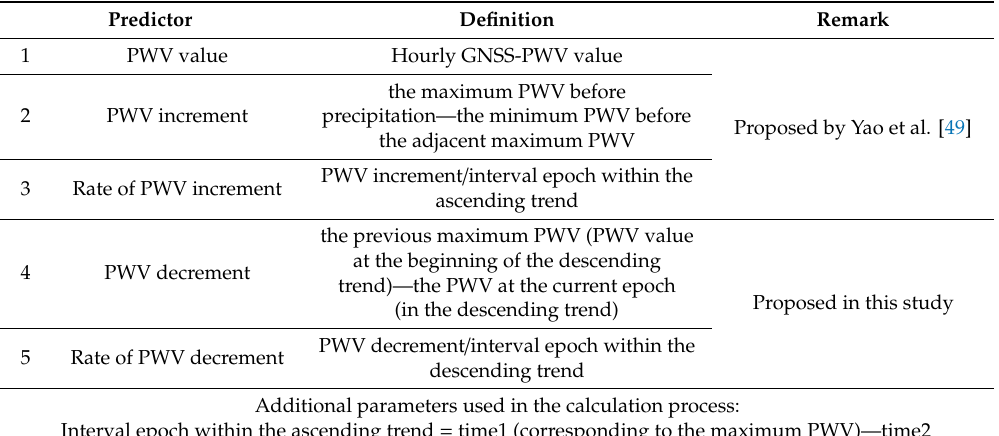
Table 6. Definitions of five predictors used in the new model proposed in this study. Predictor